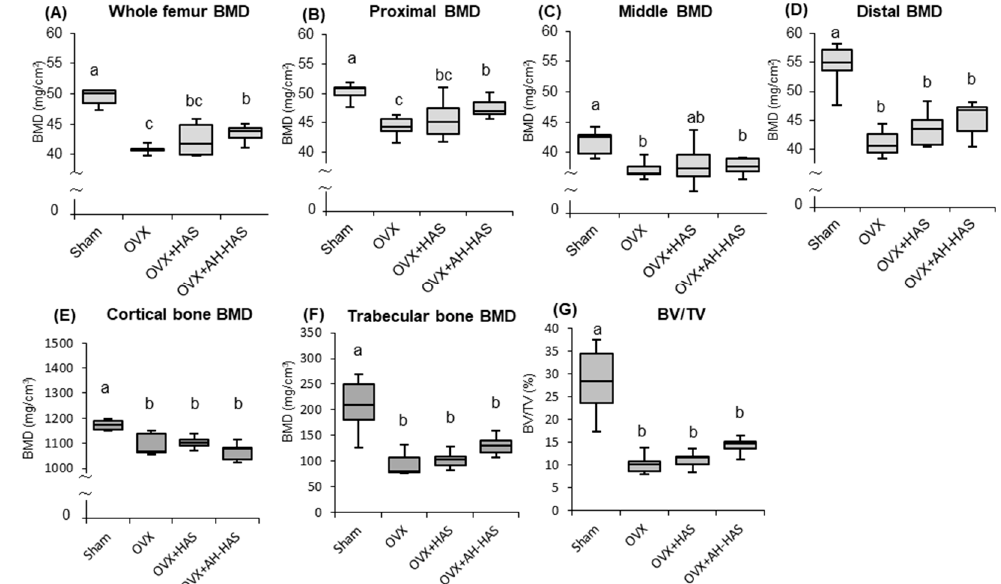
Figure 4. Bone mineral density (BMD) of the femur was obtained from sham and OVX mice fed a control diet, 20% high-amylose corn starch (HAS)-supplemented diet (OVX + HAS), or 20% acid-hydrolysed high-amylose corn starch (AH-HAS)-supplemented diet (OVX + AH-HAS) for 42 days. BMD of the ( A ) whole femur ( B ) proximal femur, ( C ) middle femur and ( D ) distal femur were analysed by DXA. BMD of the ( E ) Cortical and ( F ) trabecular bone, and ( G ) bone volume per tissue volume (BV/TV) on distal femur were analysed by uCT. Values are the mean ± SEM ( n = 8). Significant differences in BMDs were determined by analysis of covariance (ANCOVA) and the Bonferroni significant difference test. Differences were considered significant if p < 0.05. Body weight was used as a covariate in the analysis of BMDs to adjust for a possible confounding effect. a, b, c Mean values with unlike letters are significantly different.